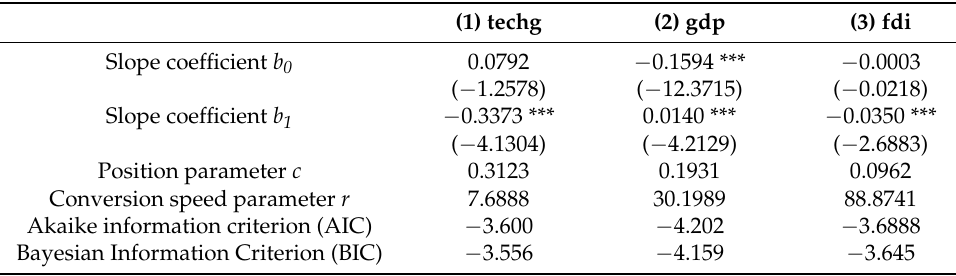
Table 5. Model regression